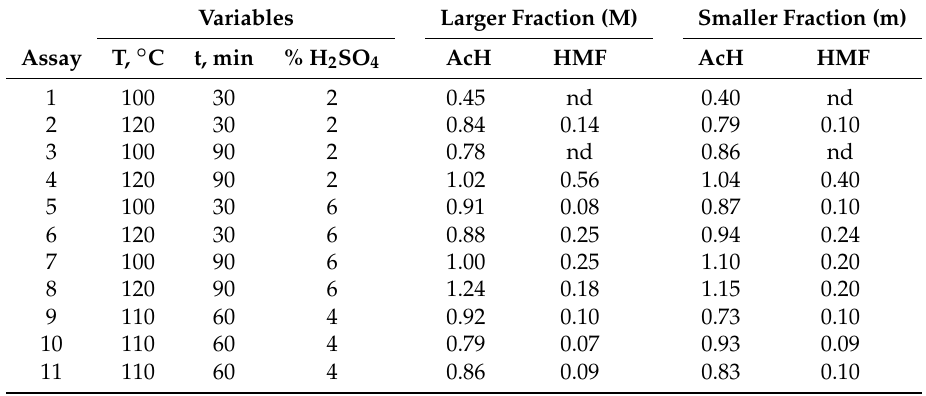
Table 4. Concentrations (kg m − 3 ) of acetic acid (AcH) and hydroxymethyl-furfural (HMF).